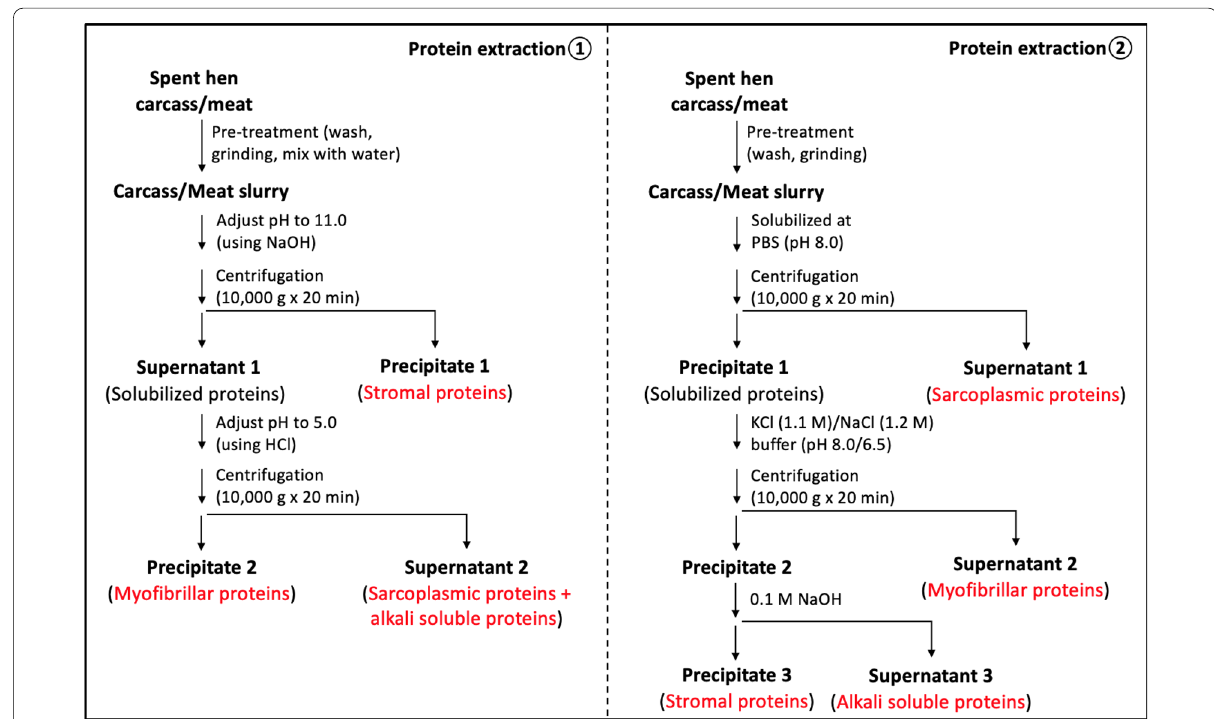
Fig. 2 Protein extraction from spent hens. Protein extraction protocol 1 was summarized from Wang and Wu (2012) and Fan et al. (2021) with slight modifications; protein extraction protocol 2 was summarized from Zubair (2017) with slight modifications. Supernatants can be freeze-dried to obtain proteins, or be further dialyzed before collecting the retainates for